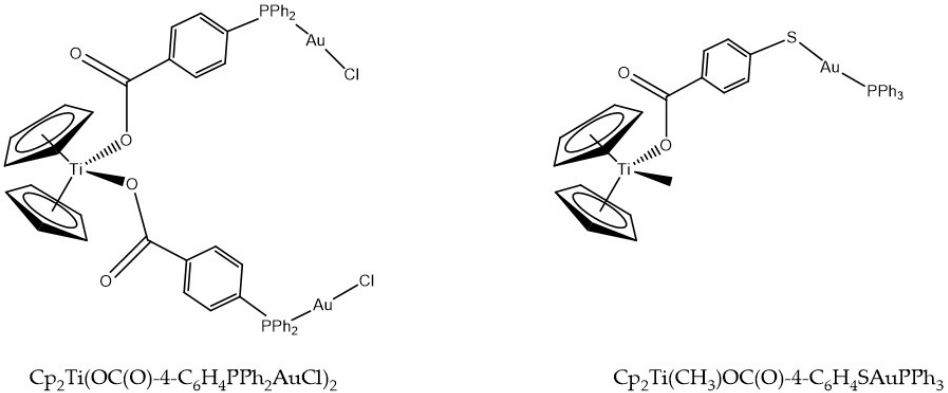
Figure 18. The chemical structures for Cp 2 Ti(OC(O)-4-C 6 H 4 PPh 2 AuCl) 2 and Cp 2 Ti(CH 3 )OC(O)-4-C 6 H 4 SAuPPh 3 .